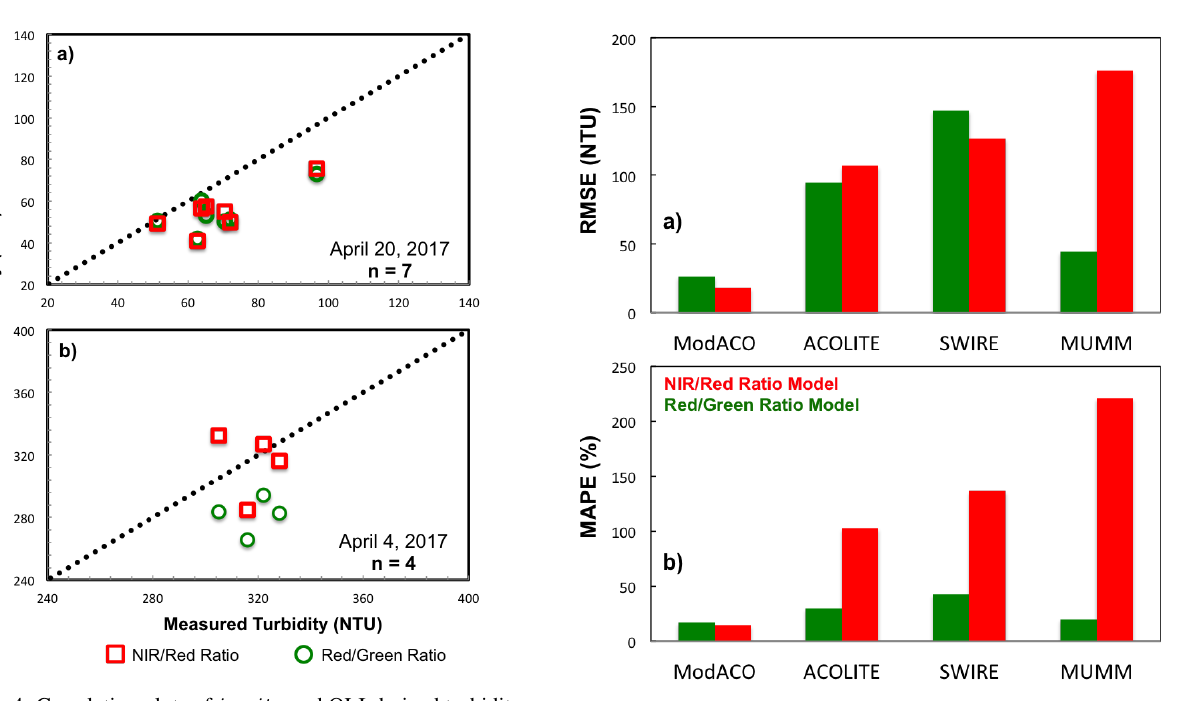
Figure 4. Correlation plots of in situ and OLI-derived turbidity Figure 5. The accuracy of turbidity models based on R rs values using R rs values derived from the ModACO scheme. The 1:1 derived different atmospheric correction line is denoted by the black dots.